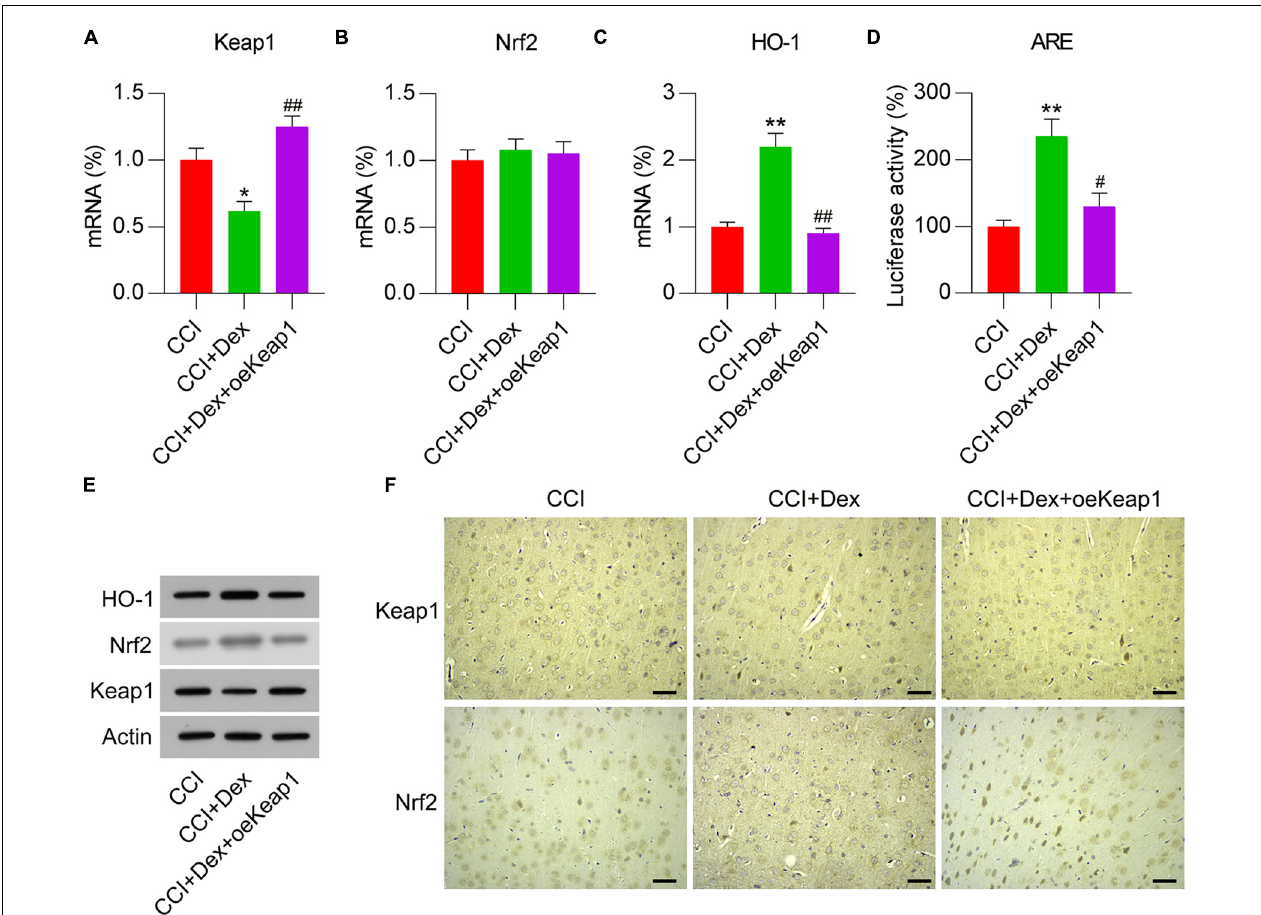
FIGURE 4 | Overexpression of Keap1 in Dex-treated CCI-induced rats intrathecally injected with lentiviral-NC or lentiviral-Keap1 for 1 week. Rats were then subjected to Dex treatment and CCI surgery. (A,B) mRNA expression levels of Keap1 and Nrf2 was measured using qPCR. (C) mRNA expression level of HO-1 in the spinal cord was detected using qPCR. (D) Isolated microglia were transfected with ARE luciferase vectors, and luciferase activity was determined in the cells at 36 h after transfection. (E) Protein expression levels of Nrf2, Keap1, and HO-1 were measured using WB. (F) Immunohistochemical staining of Keap1 and Nrf2 expression in spinal cord tissues. Scale bar, 50 µ m. * P < 0.05, ** P < 0.01 vs. CCI group; # P < 0.05, ## P < 0.01 vs. CCI + Dex group.